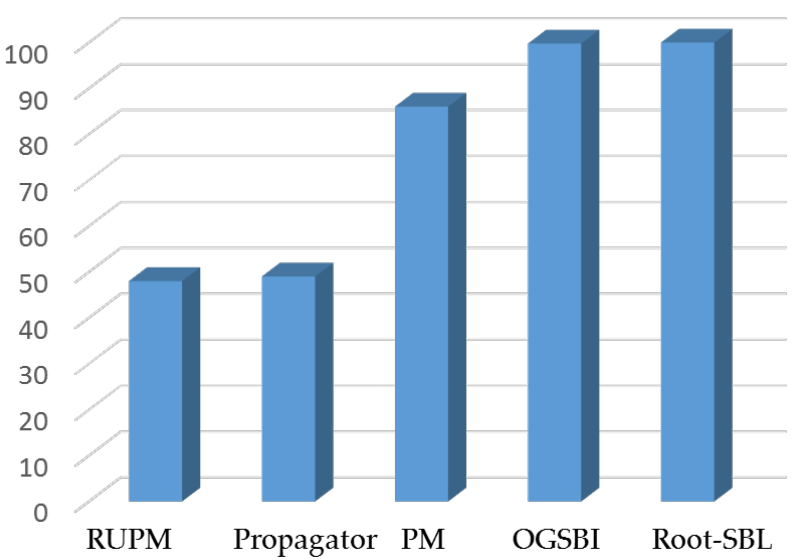
Figure 6. The percentage reduction in the execution time of the Root-UPM compared to other methods.